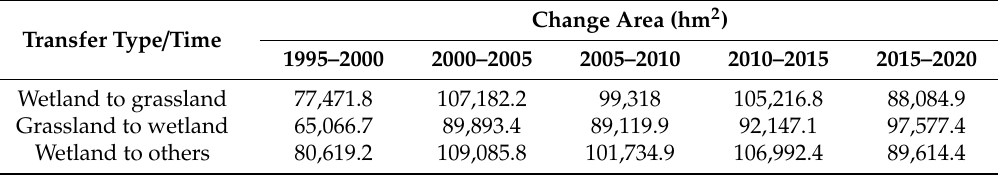
Table 8. Transfer matrix of six phases between wetland and other features.